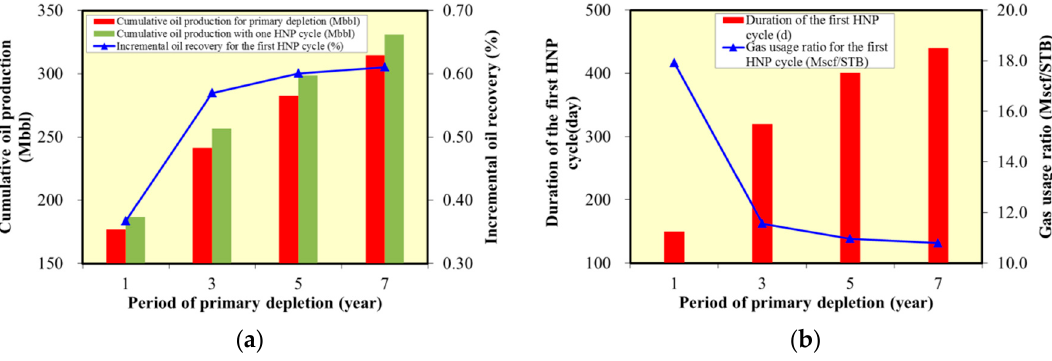
Figure 27. Correlation between the periods of primary depletion and huff-n-puff results: ( a ) Cumulative oil production and incremental oil recovery for different periods of primary depletion; ( b ) Duration of the first huff-n-puff cycle and gas usage ratio for different periods of primary depletion.